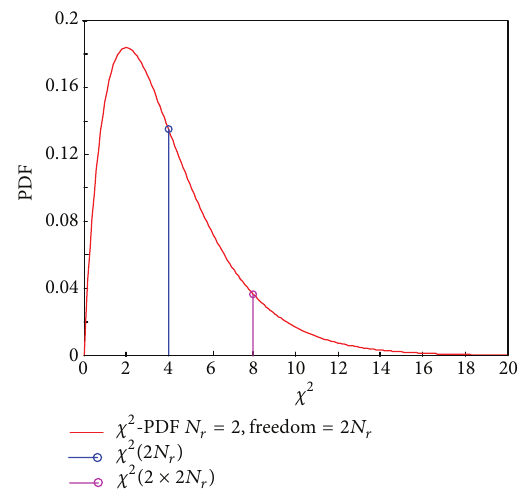
Figure 1: PDF of the channel columns with Frobenius